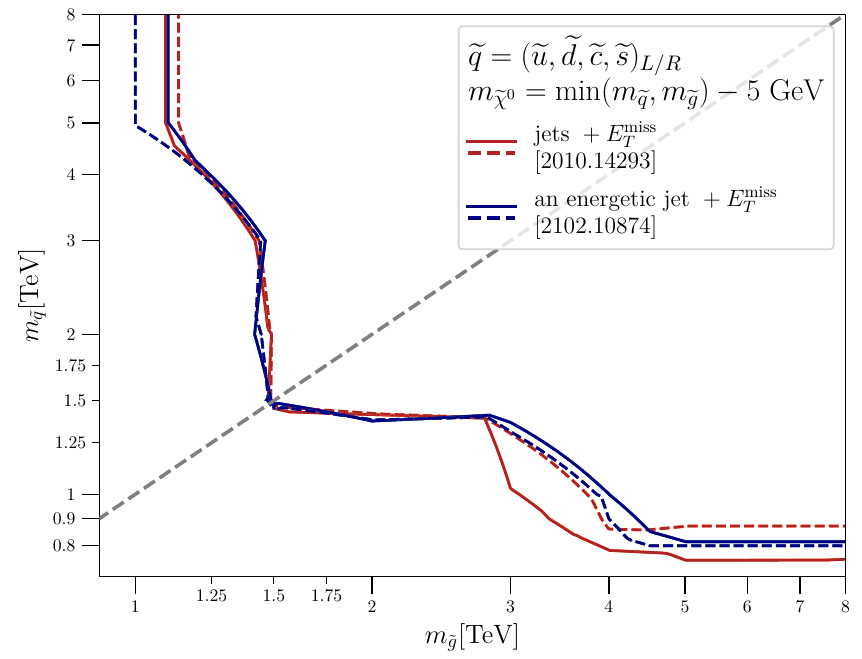
Figure 10 . The exclusion limit in the ( m ˜ g , m ˜ q ) plane with constraint m ˜ χ 0 1 = min( m ˜ g , m ˜ q ) − 5 GeV. The blue and red contours represent the limits obtained from the ATLAS “an energetic jet + E miss ” [5] and “jets + E miss ” [10] analyses, respectively. The solid and dashed contours correspond T T to the observed and expected limits, respectively. The diagonal grey dashed line indicates m ˜ g = m ˜ q . excluded regardless of the squark mass. In a moderately hierarchical mass region, m ˜ g & m ˜